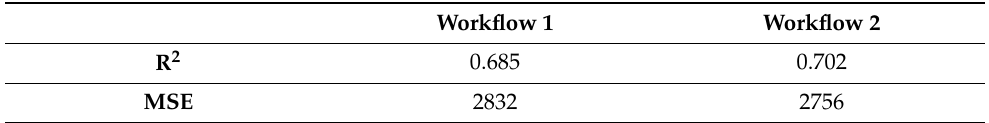
Table 3. Validation of workflows 1 and